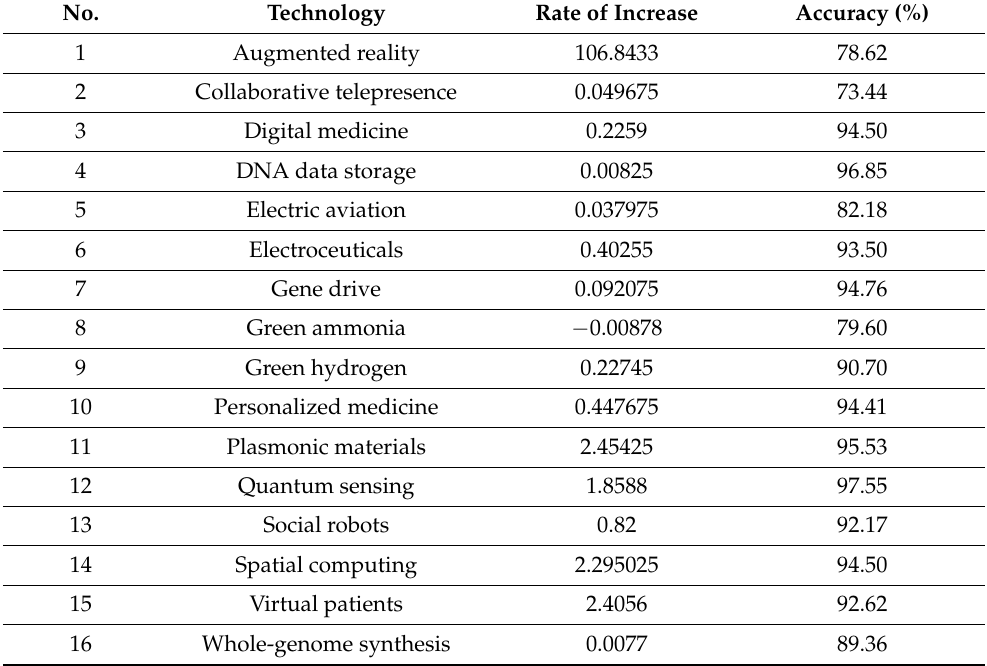
Table 3. Rate of increase and prediction accuracy of the predicted number of patents by technology.